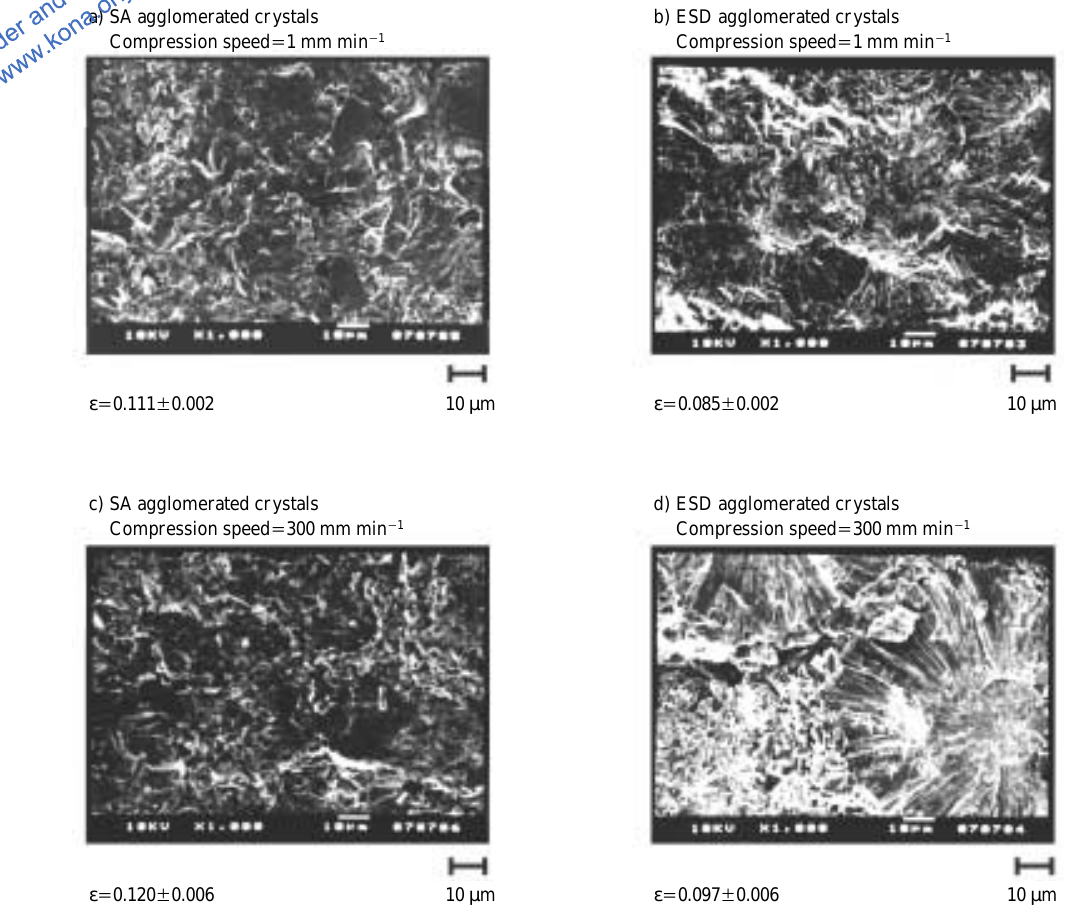
Scanning electron photomicrographs of cross section of ascorbic acid tablets prepared by static